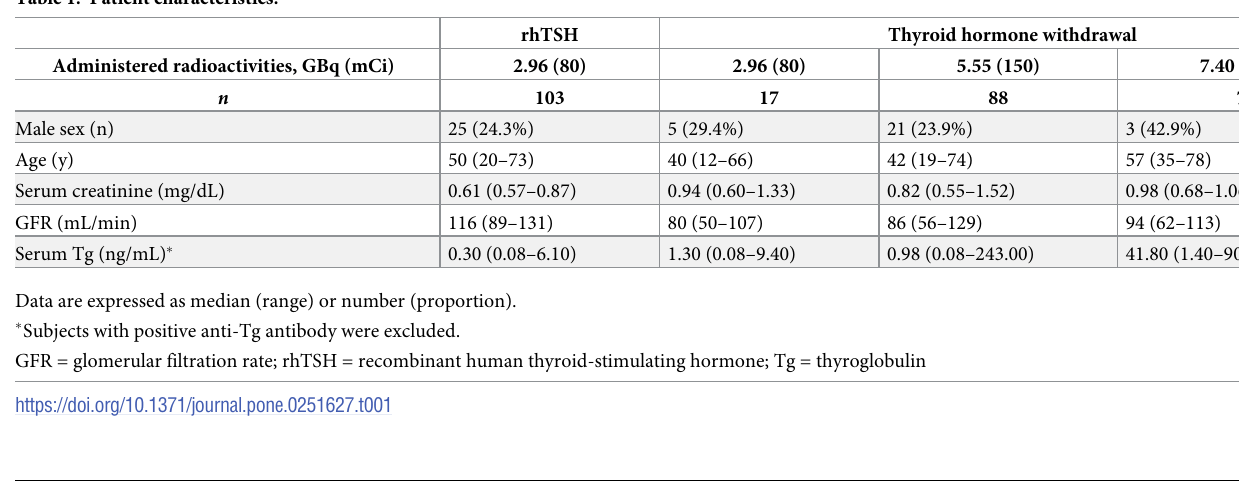
Table 1. Patient